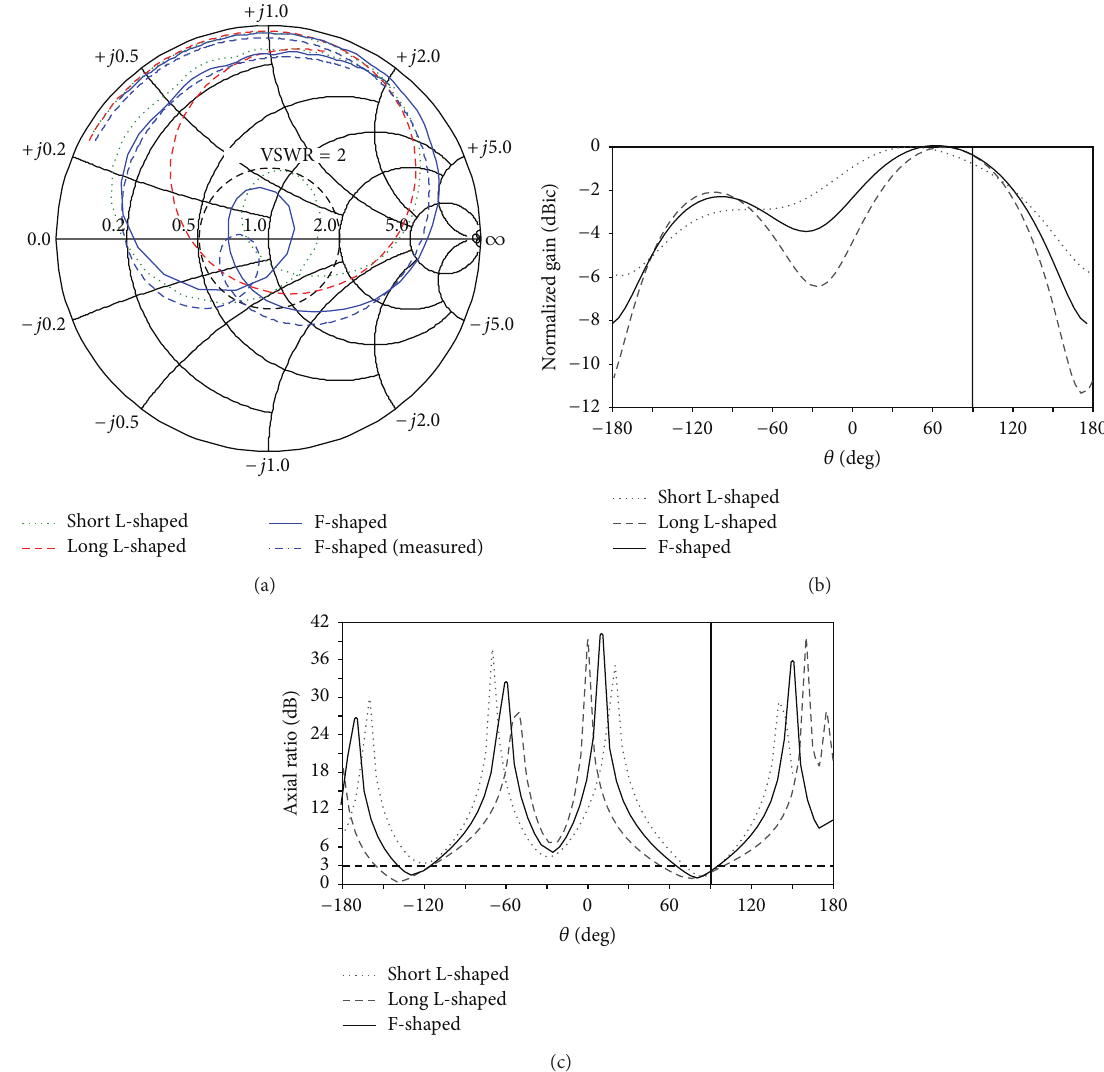
Figure 11: Simulated results of (a) input impedance characteristics, (b) antenna gain, and (c) AR pattern with 𝜃 . 𝜙 = 90 ∘ in y-z plane at 925 MHz when the short, long, and F-shaped stubs are